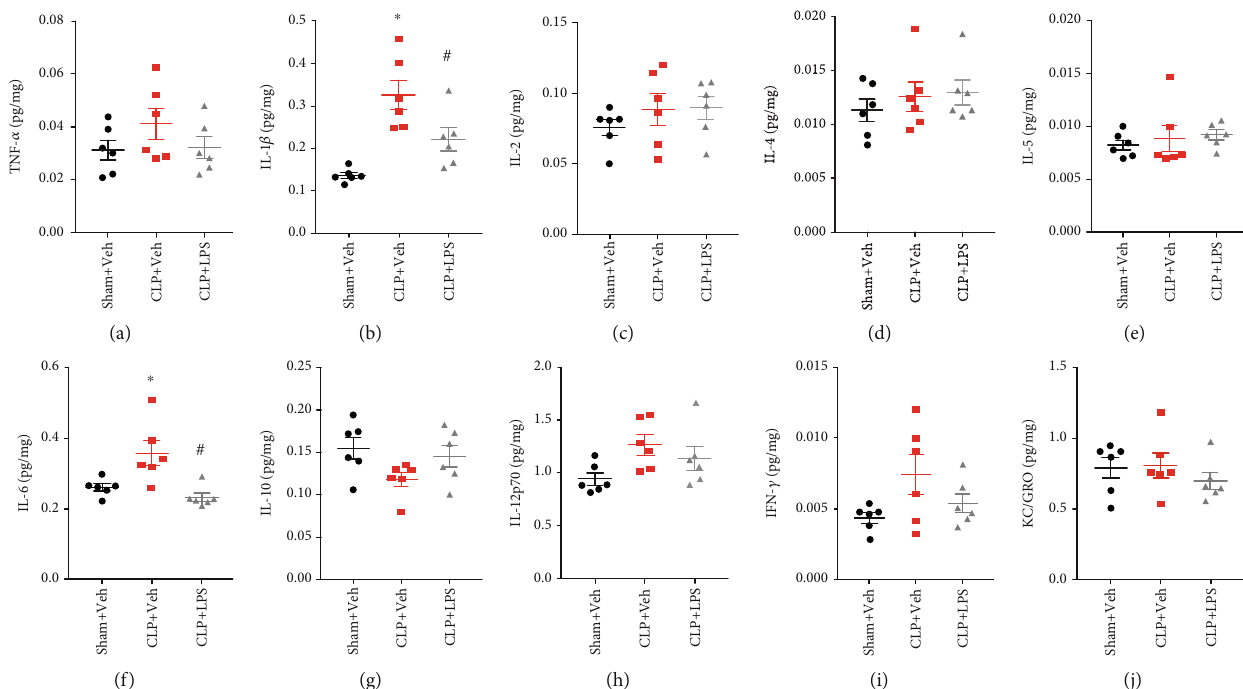
Figure 4: E ff ects of repeated LPS injections and CLP on hippocampal cytokines. Tissue ELISA showed increased IL-1 β and IL-6 levels in the hippocampus following CLP, which were prevented by repeated LPS injections. Data represent mean ± SEM ; n = 6 /group. ∗ P < 0 : 05 vs. sham + Veh group; # P < 0 : 05 vs. CLP+Veh group. LPS: lipopolysaccharide; CLP: cecal ligation and puncture; Veh: statistic = 12 : 04 , P = 0 : 0002 ), and IL-6 ( Kruskal – Wallis